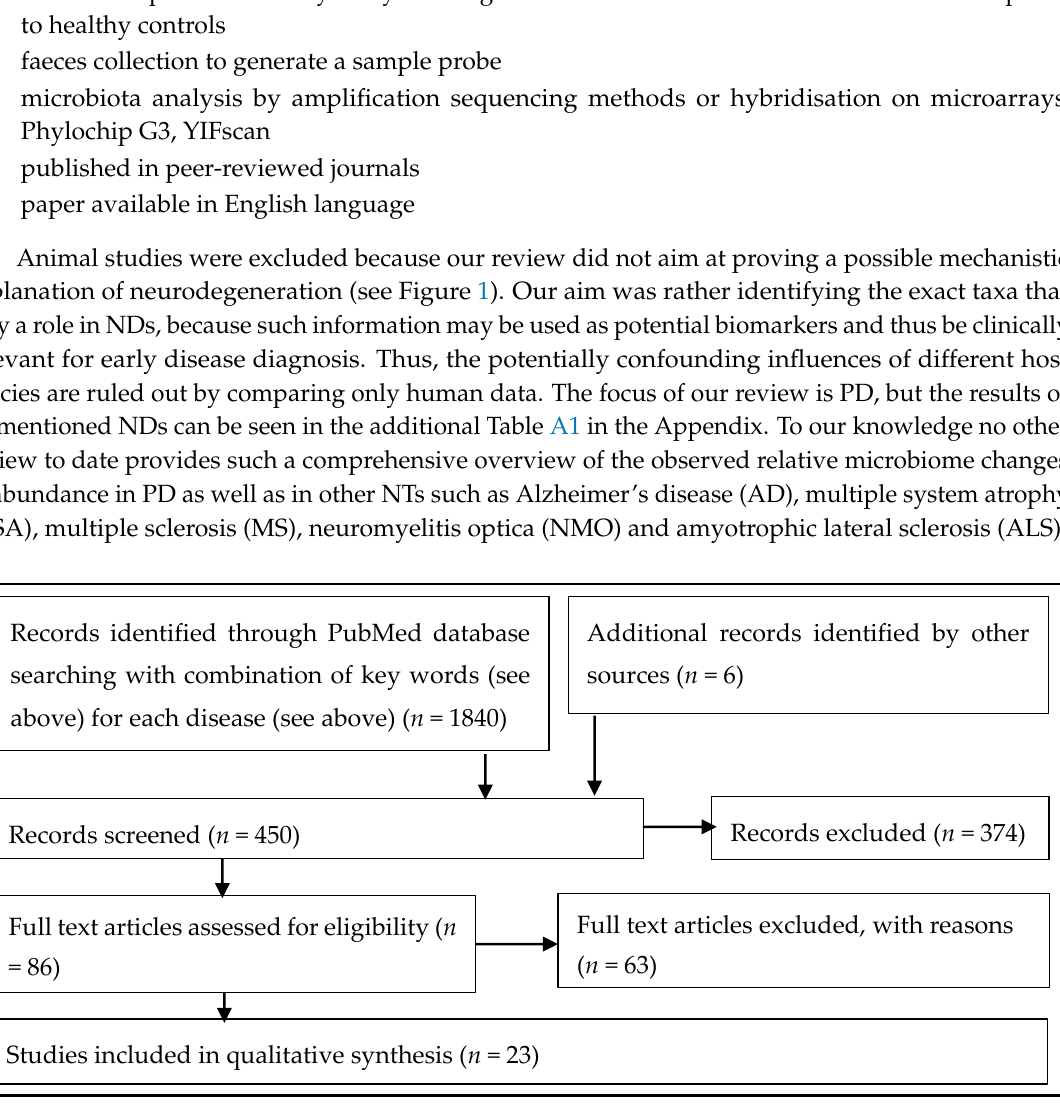
Figure 1. Methodical approach of systematic review due to PRISMA criteria (PRISMA criteria [33]).